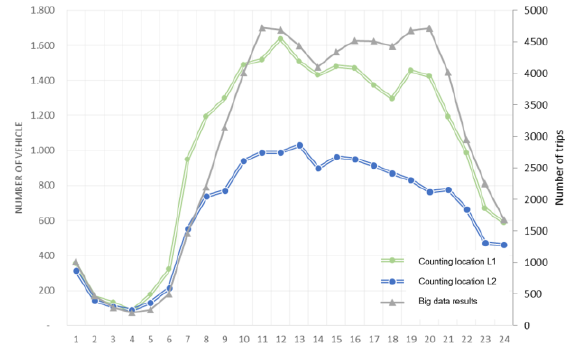
Figure 5 . Comparative analysis - daily unevenness of traffic flow (a characteristic day of the week)